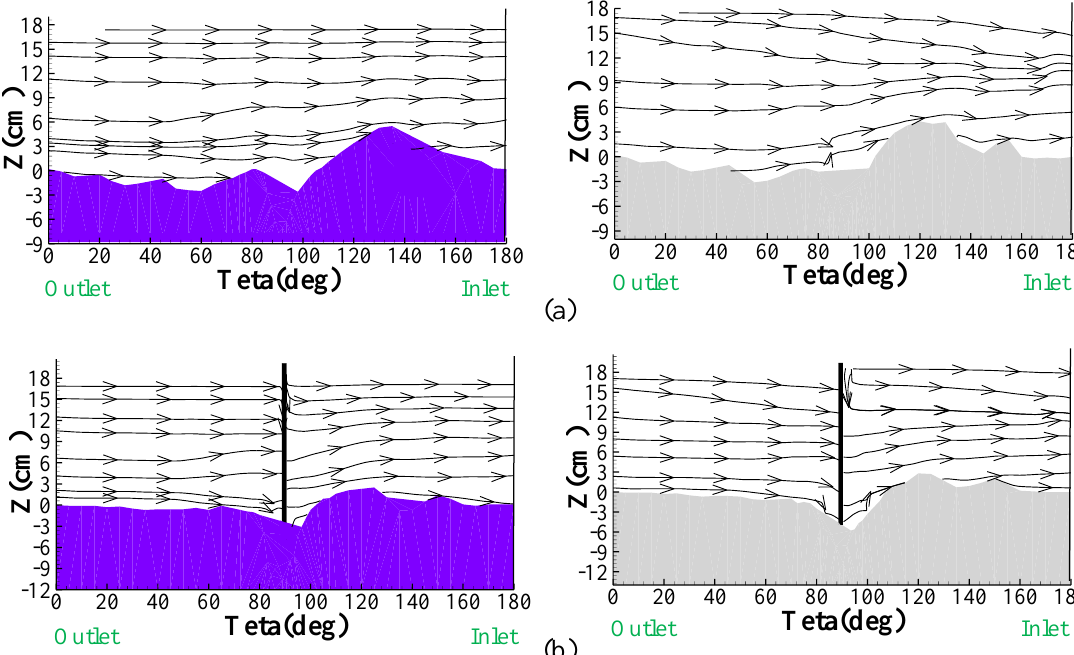
Figure 7. A view of the flow pattern at different longitudinal sections of the 180 degree bend, at a distance of a) 30, and b) 50% of the channel width from the inner bank. (PFV experiment on the right, and PSV experiment on the